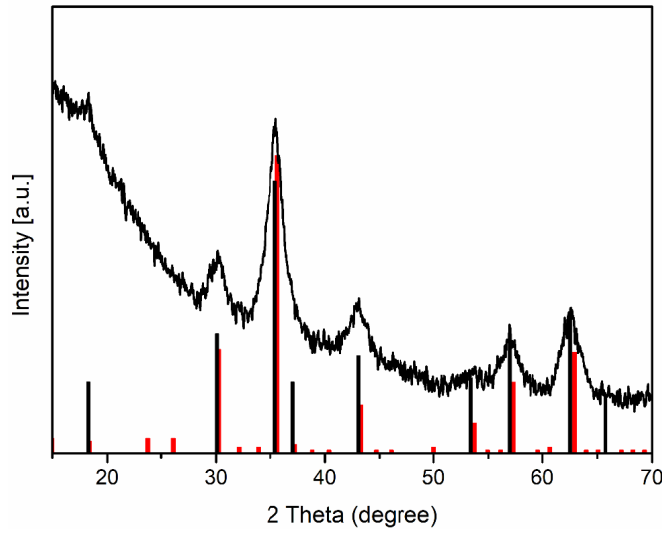
Figure 2. XRD patterns of dextran coated iron magnetic nanoparticles and reference patterns for (black) Fe 3 O 4 PDF #65-3107 and (red) γ -Fe 2 O 3 PDF # 25-1402.